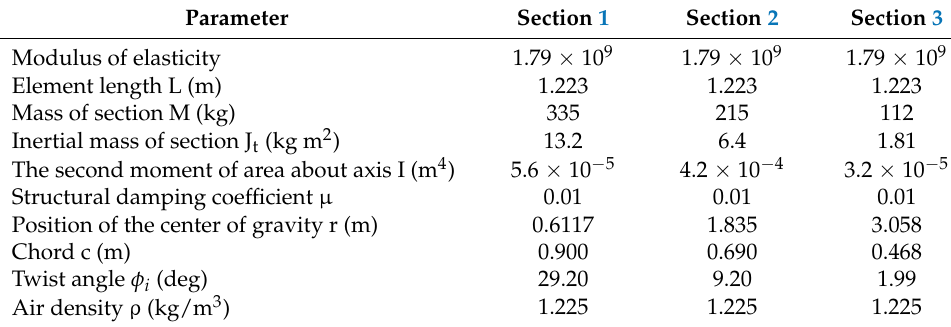
Table 2. Input parameters of the modeled blade (Metehara site).